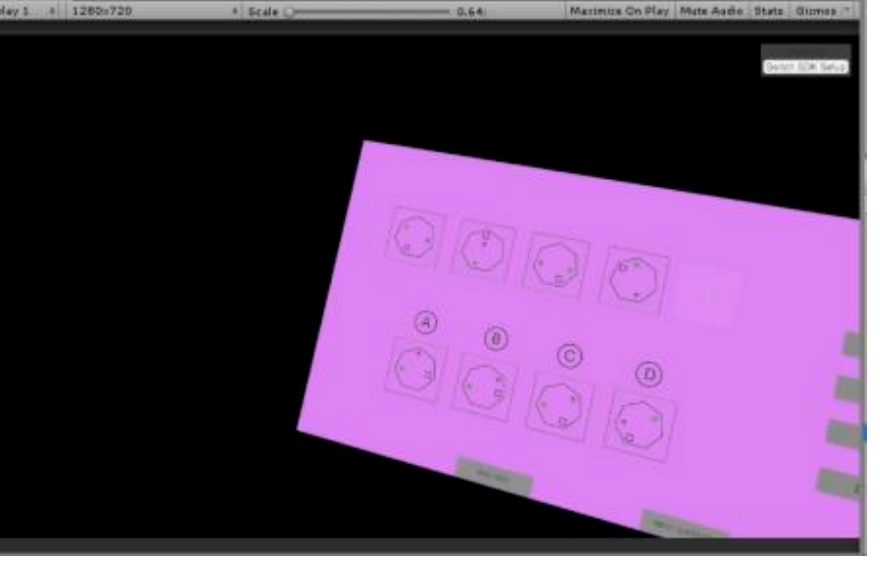
Figure A3. Examples of experimental setup.